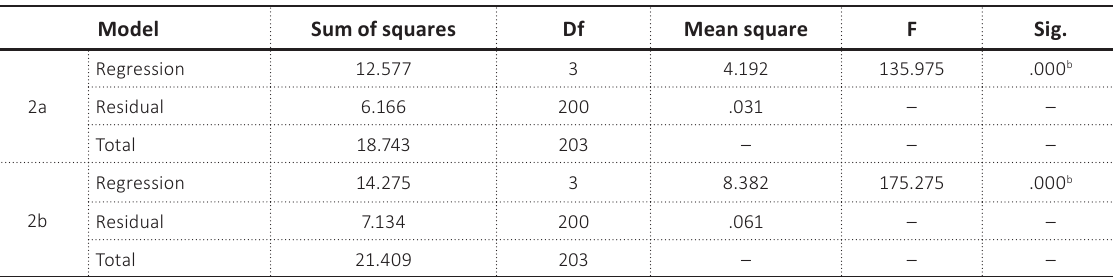
Source: Field survey (2019).